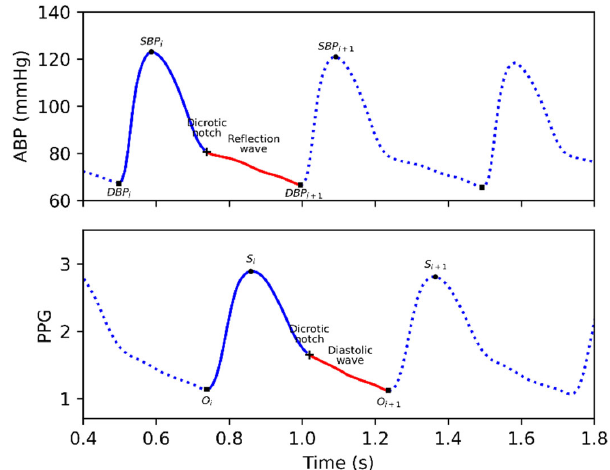
Figure 1. A synchronized ABP and PPG signal. SBP i and DBP i in ABP refer to the i th systolic and diastolic blood pressure, respectively. O i and S i stand for the i th onset and systolic peak, respectively. For the i th beat, the blue line is the systolic wave in ABP and PPG. This figure was used to show the correlation between ABP and PPG. Note that PPG = Photoplethysmogram, ABP = Arterial blood pressure, SBP = Systolic blood pressure, and DBP = Diastolic blood